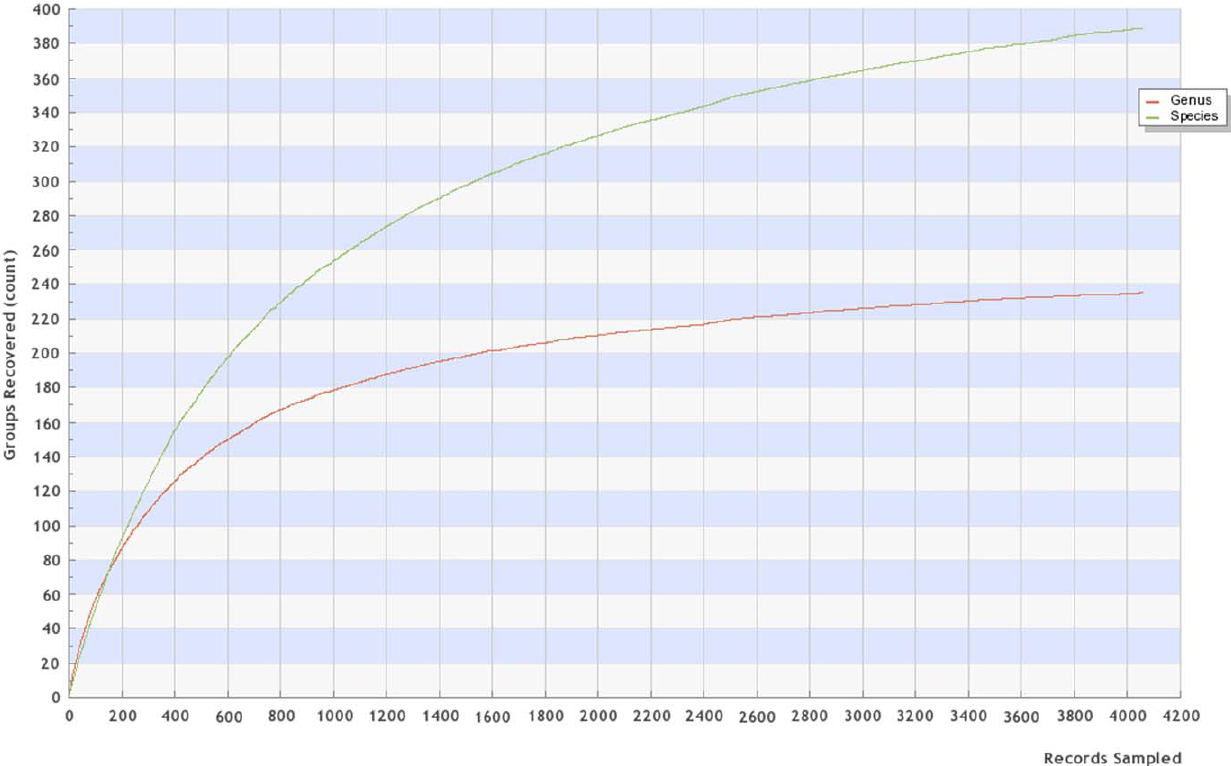
Table 1;www.boldsystems.org) and in GenBank (Accession